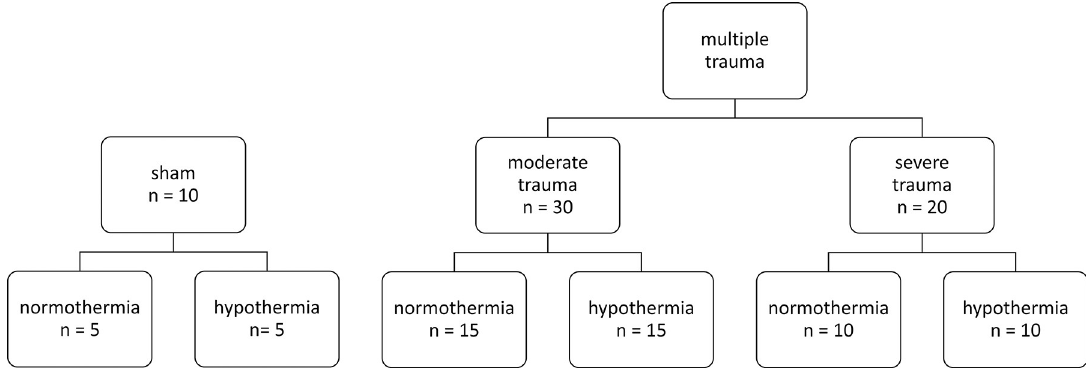
Fig 1. Study groups. Sixty animals were randomly assigned to six study groups. Sham represents the placebo surgery group. Multiple trauma included lung contusion, liver laceration, tibial fracture, and hemorrhagic shock (moderate or severe). Intervention with mild hypothermia (33˚ C) for 12 hours and subsequent rewarming over 10 hours. Animals in the normothermia group were kept at 38˚ C core